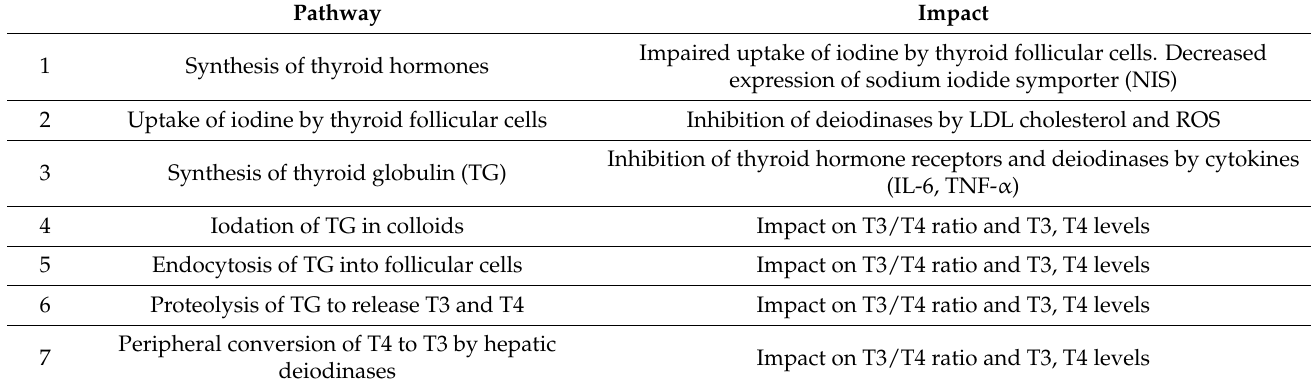
Table 3. Summary of the pathways through which the accumulation or depletion of intermediates due to metabolic syndrome causes disease and their